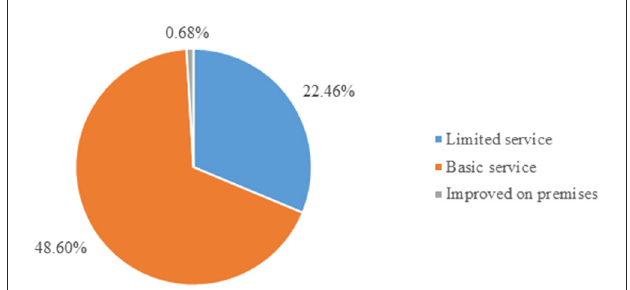
Figure 4 indicated that the subgroup analysis of the pattern for